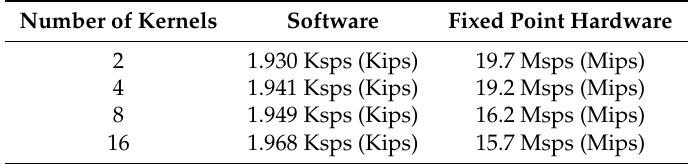
Table 6. Throughput, th , of the XOR gate dataset—fixed